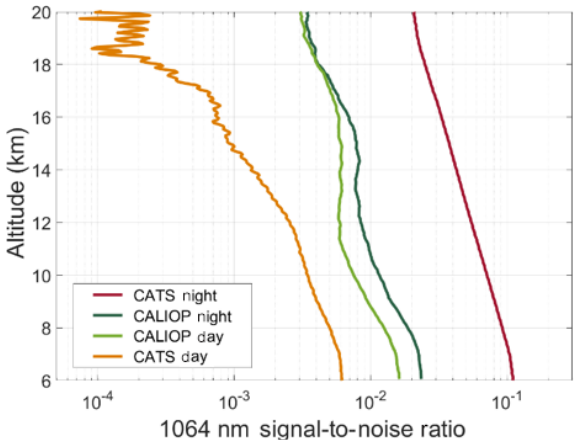
Figure 1. The CATS and CALIOP 1064nm signal-to-noise ratios for both daytime and nighttime data. The CATS nighttime SNR is nearly an order of magnitude greater than CALIOP (day and night), while the CATS daytime SNR is lower than CALIOP. The CATS profiles are computed for data acquired at a laser pulse rate of 4kHz and averaged to 350m horizontally. The CALIOP profiles are cal- culated for individual laser pulses acquired at 20.16Hz, equivalent to a horizontal resolution of 335m. The initial vertical resolution for all profiles is 60m. All profiles are subsequently smoothed using a 2km (34 point) running